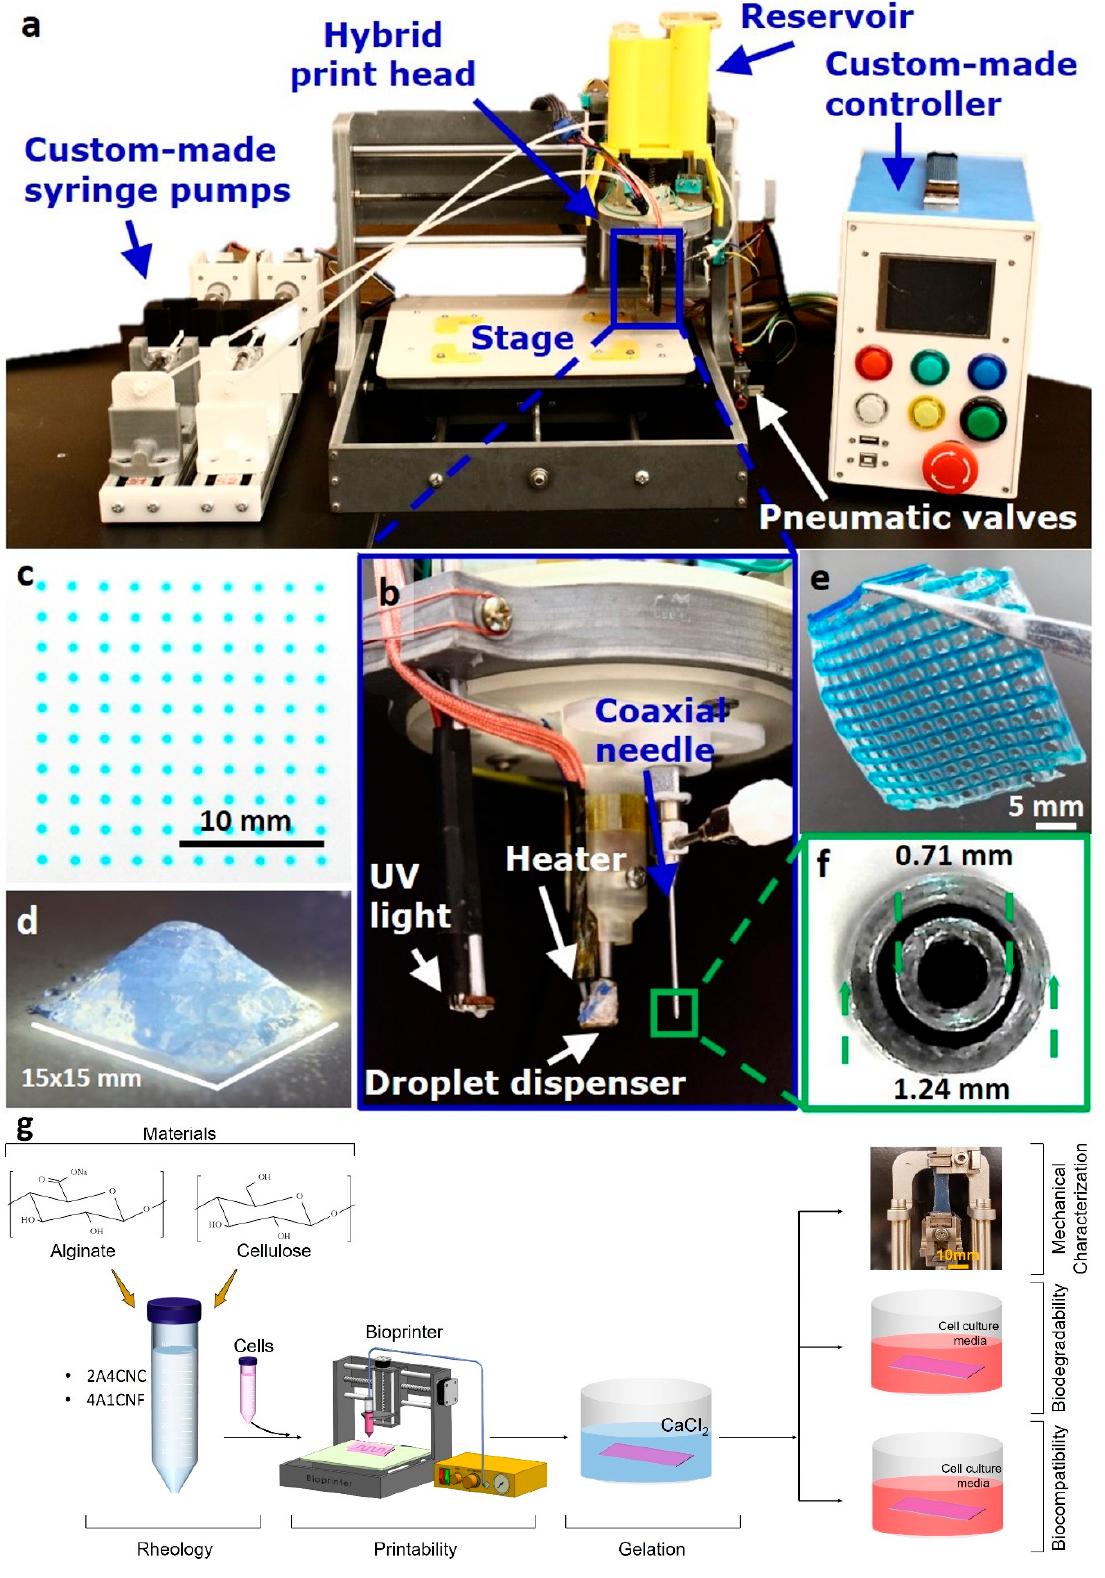
Figure 1. ( a – f ) Images of our custom hybrid bioprinter developed previously and given here for completeness. Reproduced with permission from [51]. The custom printer includes a cell-laden droplet dispenser for inkjet 3D bioprinting, a UV light source for photo-crosslinking, and a coaxial head for extrusion-based 3D bioprinting. ( g ) Schematic illustration of the experimental workflow in the current article.